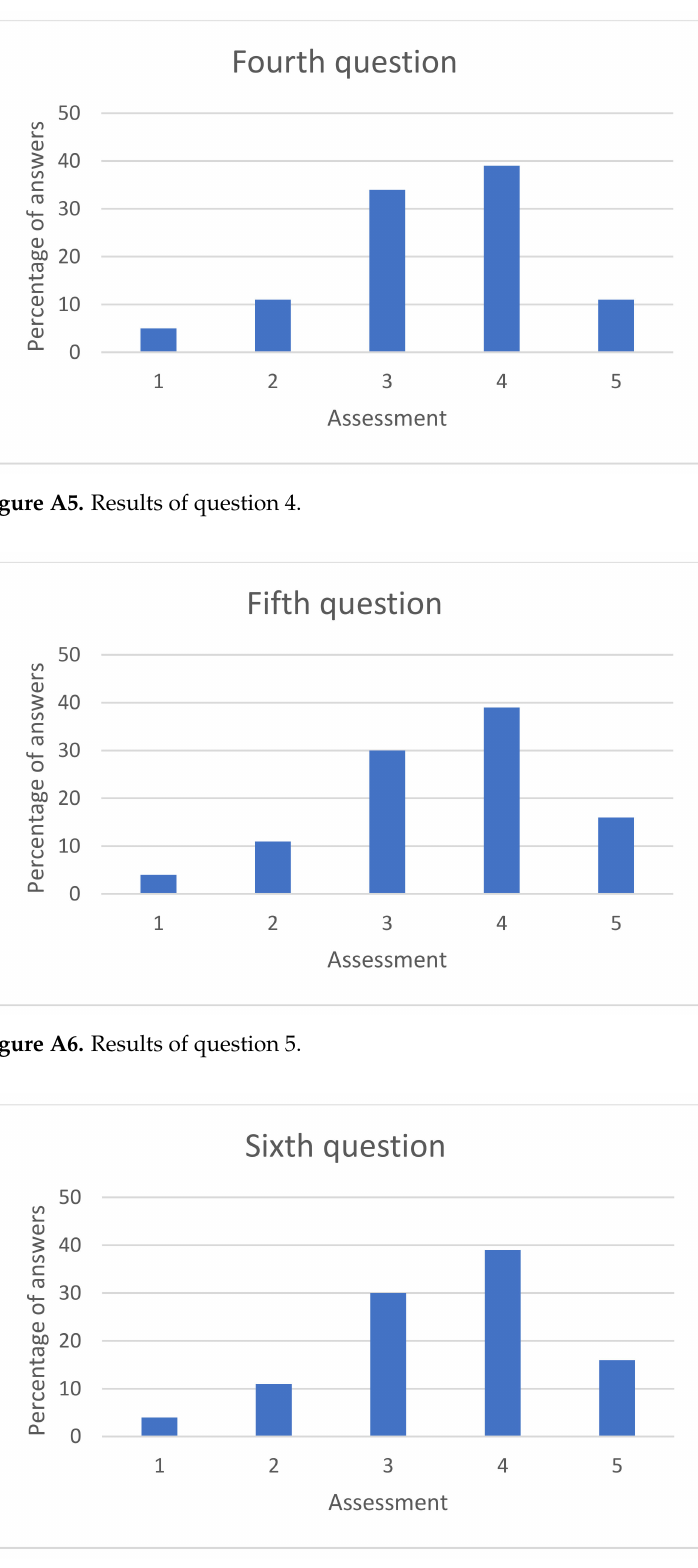
Figure A7. Results of question